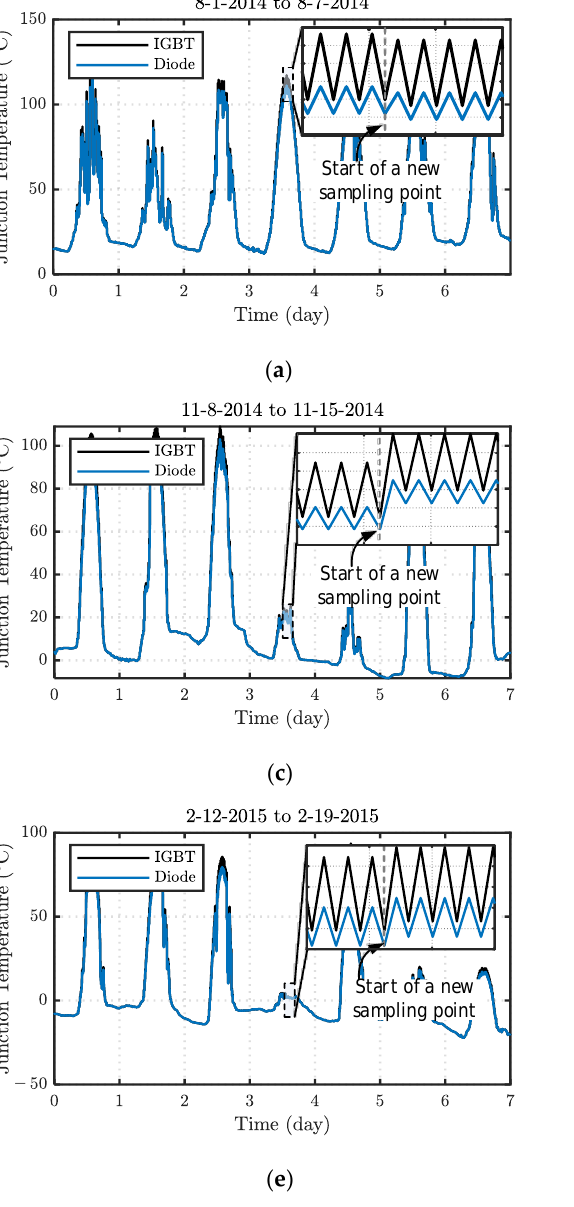
Figure 11. Flow chart of the proposed fatigue simulation [40].